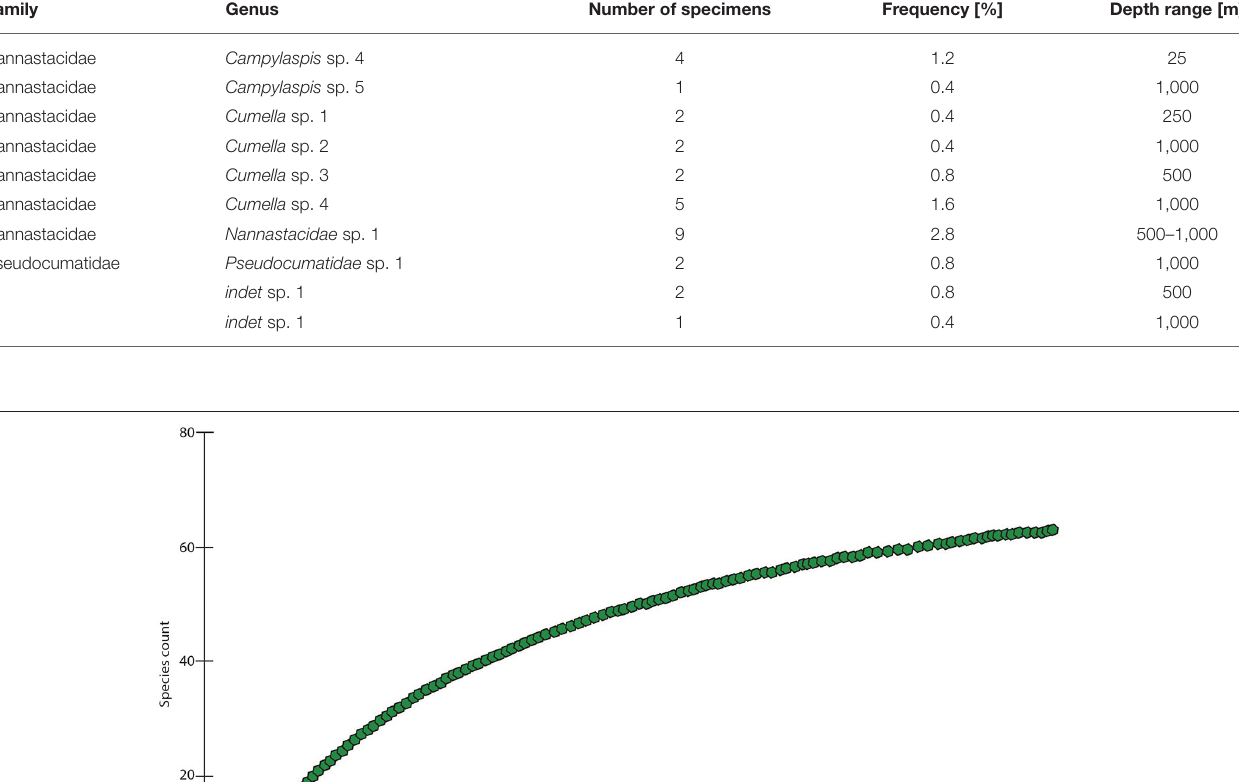
Within cluster C, 28 species in total were observed, and 16 species belong to family Bodotridae. The most speciose genera were Eocuma with six species and Bodotria with five